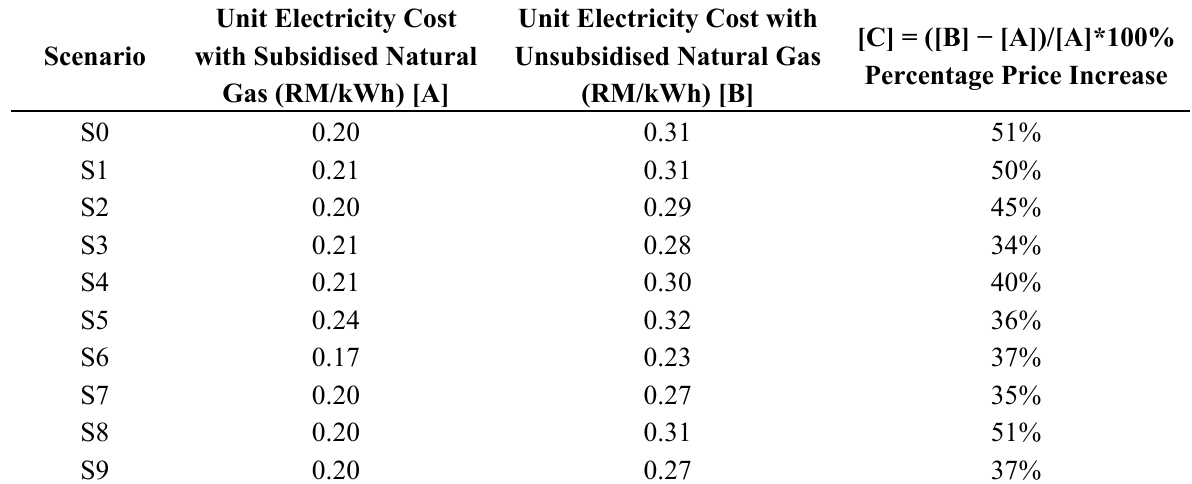
Table 4. The impact on electricity generation cost by removing subsidy on natural